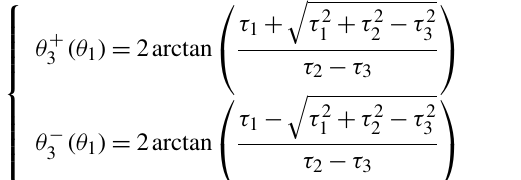
Figure 4. Constructions of the driven link of spherical 4R linkage.